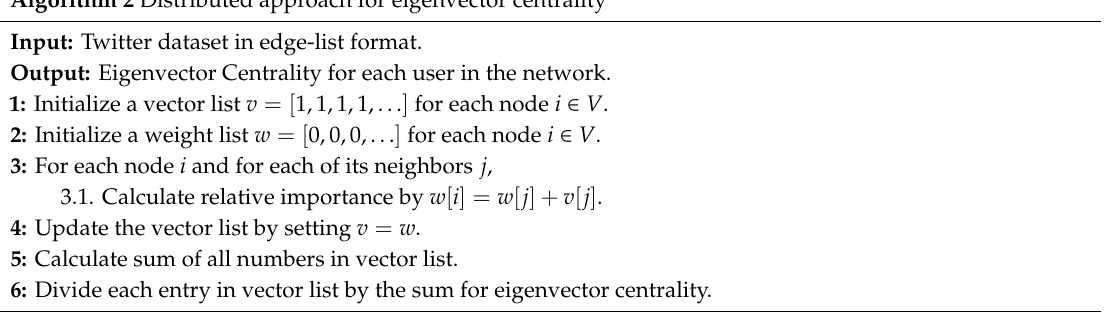
Algorithm 2 Distributed approach for eigenvector